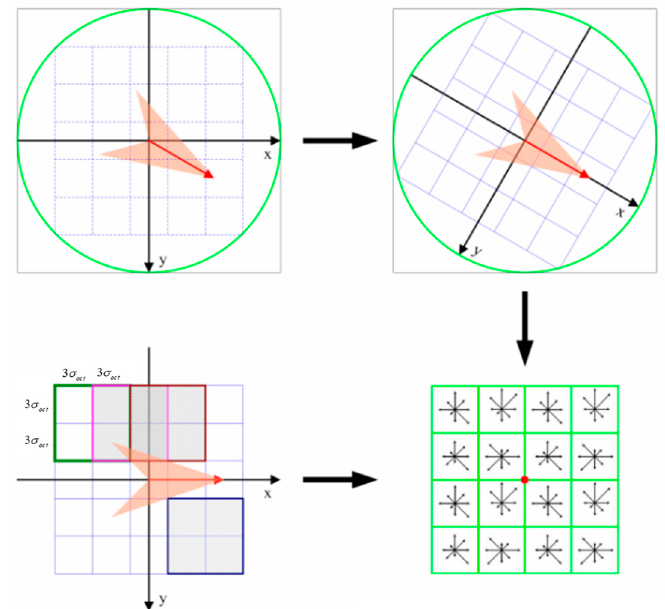
Figure 6. The feature descriptor of a feature point.